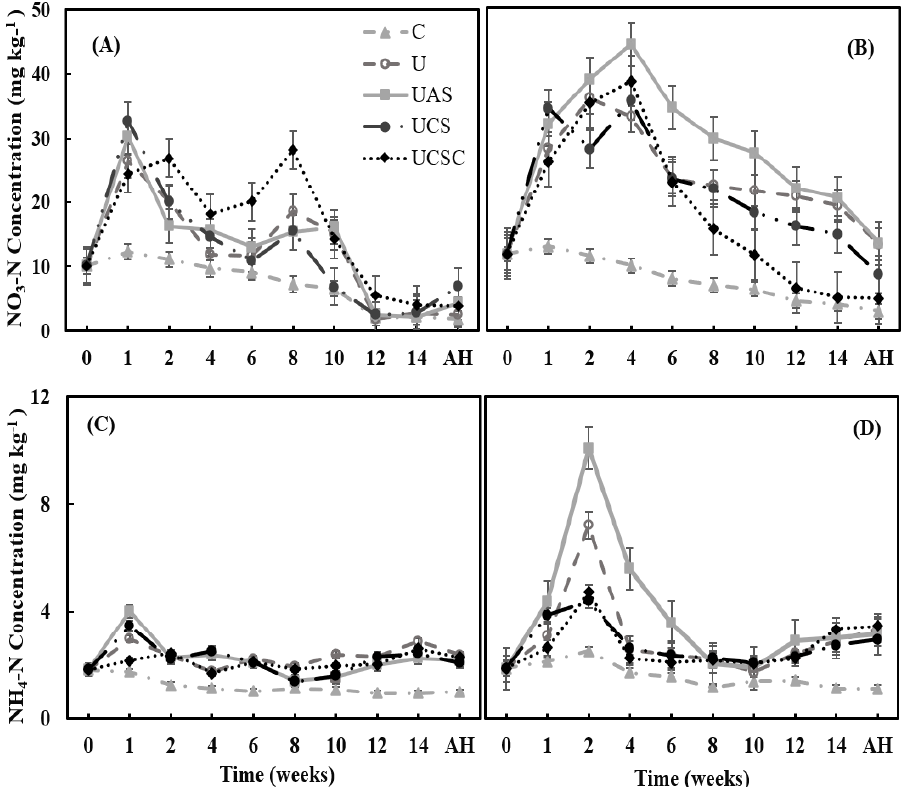
Figure 2. The release of nitrate NO 3 -N ( A , B ) and ammonium NH 4 -N ( C , D ) with time from